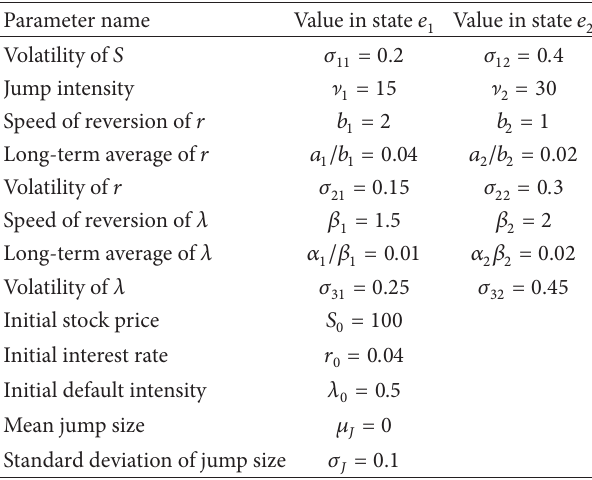
Table 1: The parameter values.